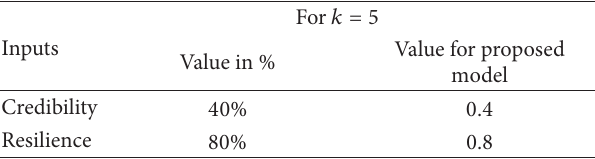
Table 3: Inputs and value for the proposed model.